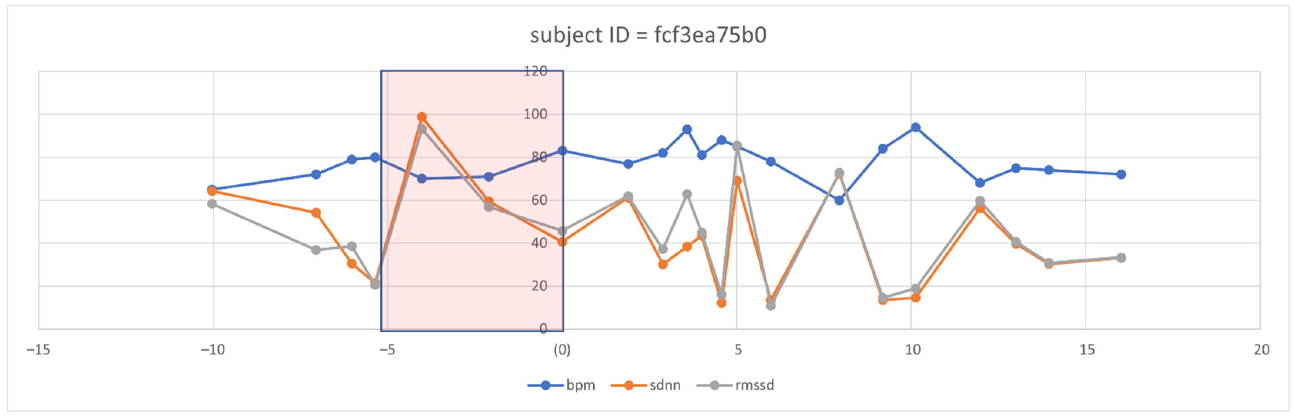
Figure 7. HRV features, BPM and feeling assessment distribution in the healthy and the infection time periods.